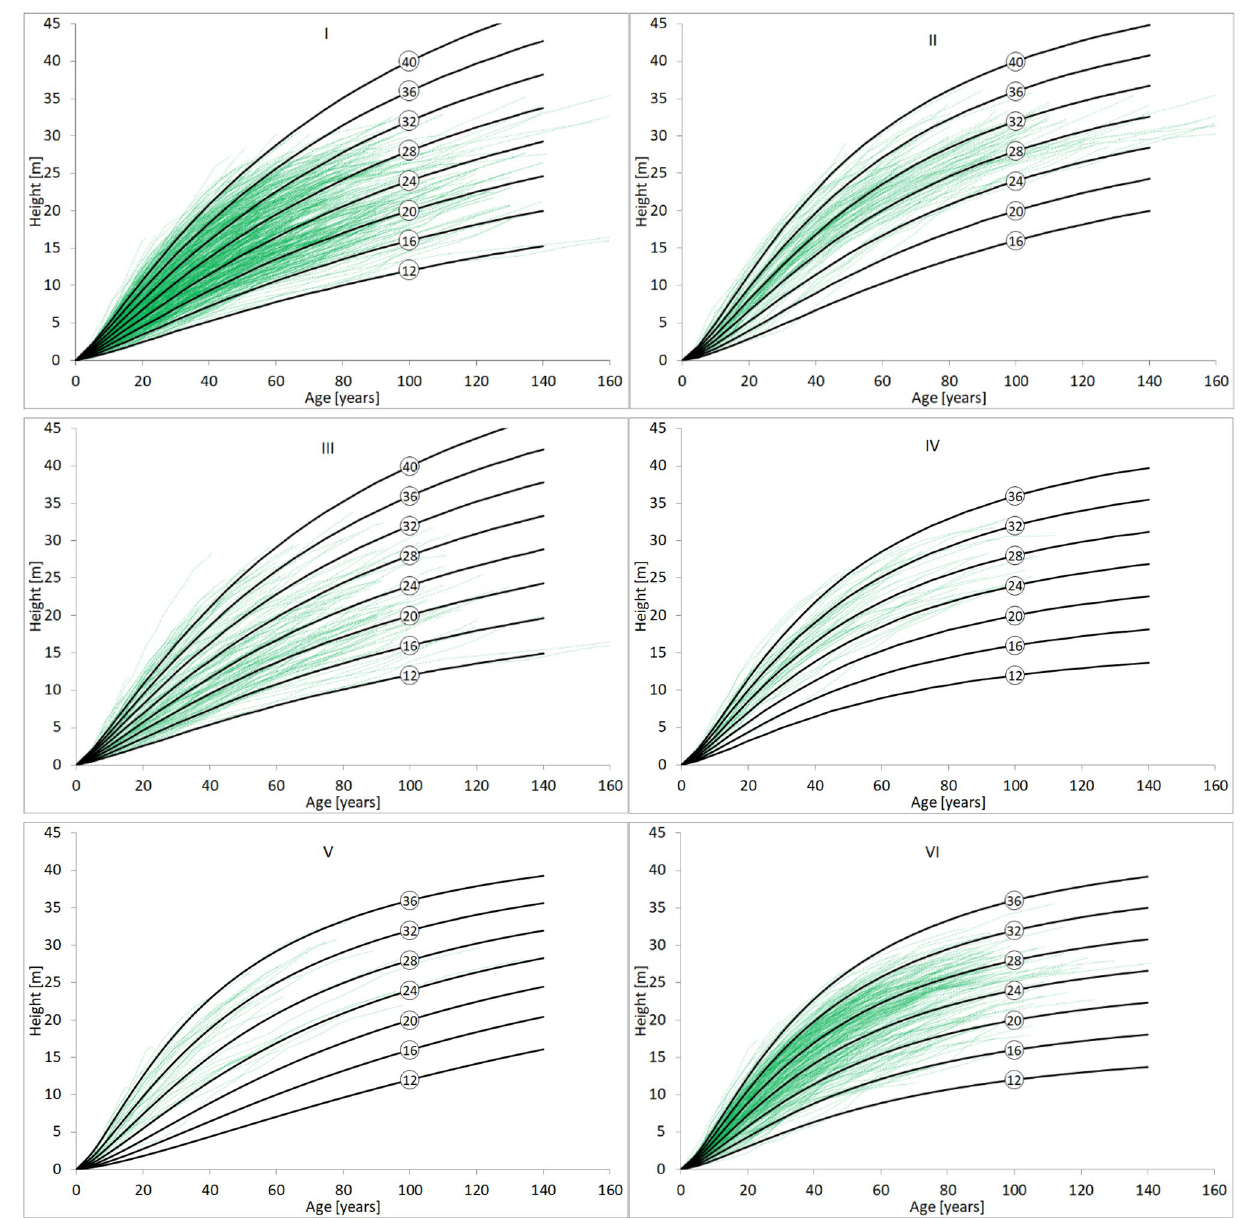
Figure 5. Regional nonlinear fixed-effects model height trajectories against the observed growth series from stem analysis collected in natural forest regions